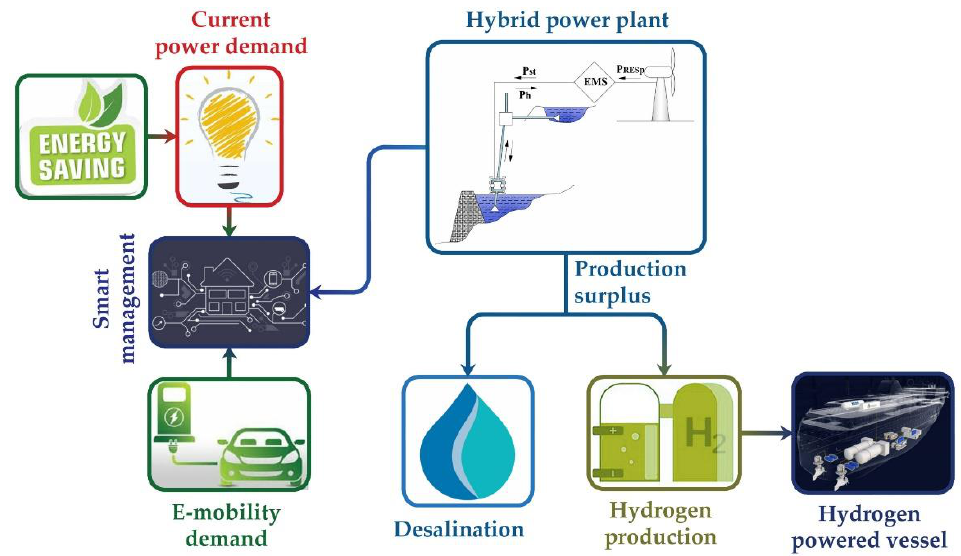
Figure 19. The overall energy transition plan on Sifnos with the opening developmental perspec-